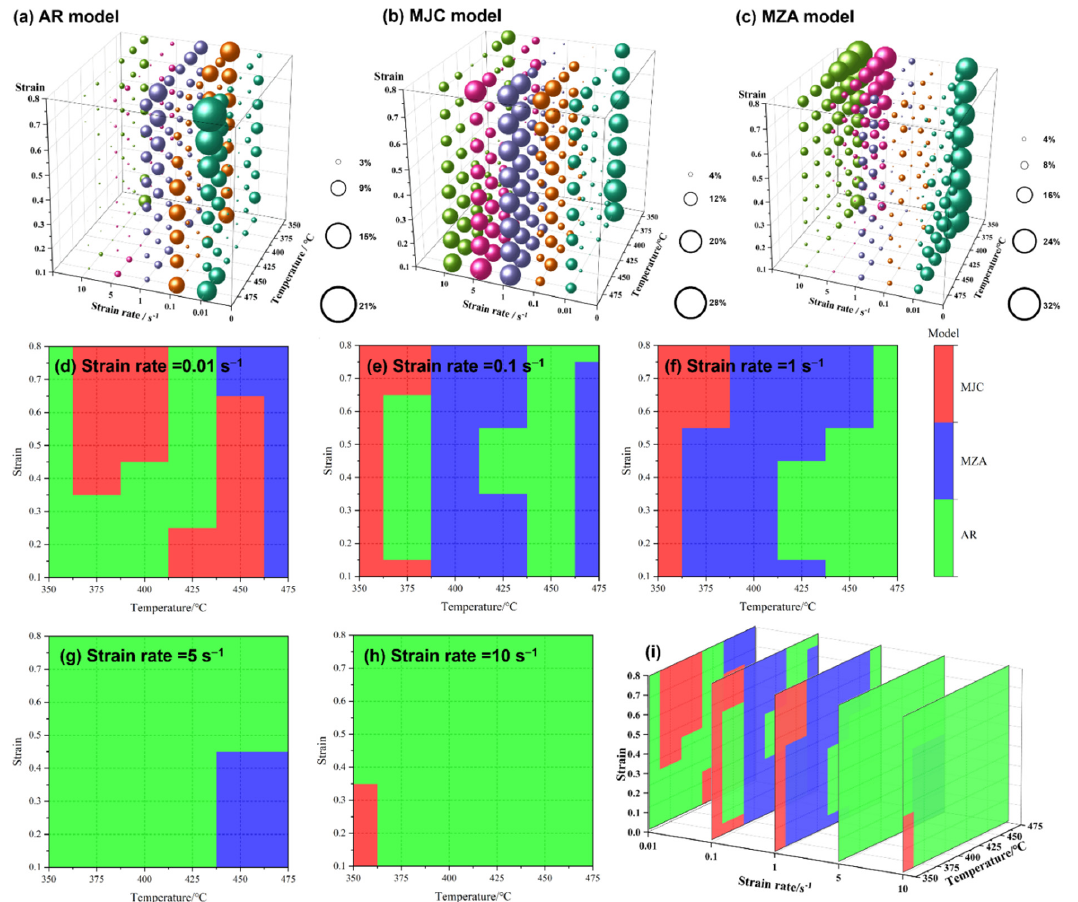
Figure 21. ( a – c ) Point-by-point error under different process conditions of the three models; ( d – h ) Diagram of the best-fit model with different process parameters-2D; ( i ) Diagram of the best-fit model with different process parameters ‐ 3D.